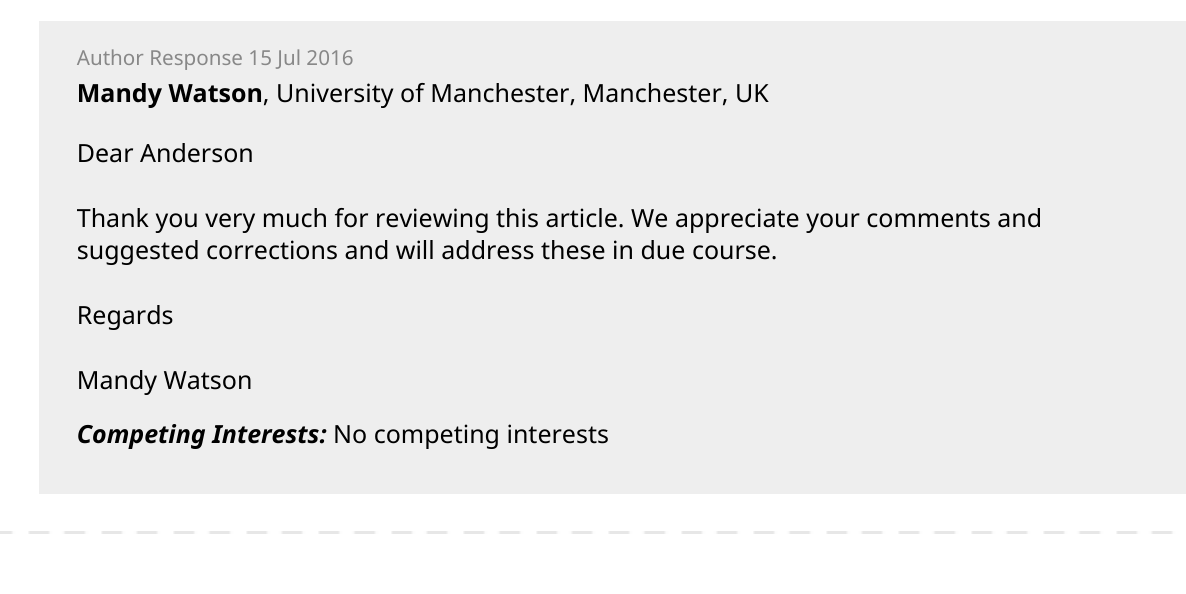
Figure 4. Not clear why some arrows in figure are there. Eg Arrow from in vivo PK to MZCRC1 POM/POP assay, or double-headed arrow from in vivo PK to in vitro DMPK